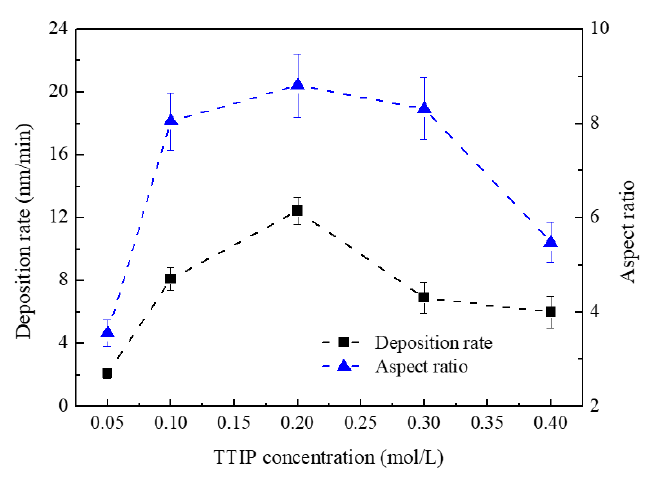
Figure 7. Deposition rate and aspect ratio of TiO 2 nanosheets.